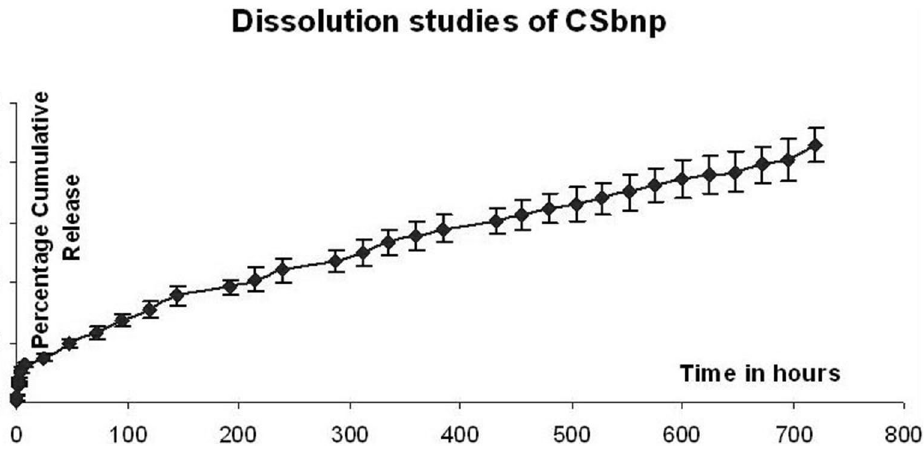
Figure 3. In-vitro dissolution studies for CSbnp. Results expressed as mean 6 SD (n=4). In vitro release of Sb from CSbnp was plotted as average percentage cumulative release over time.